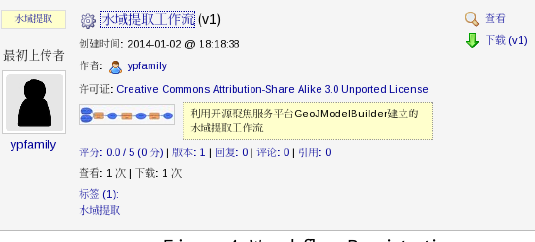
Figure 4. Workflow